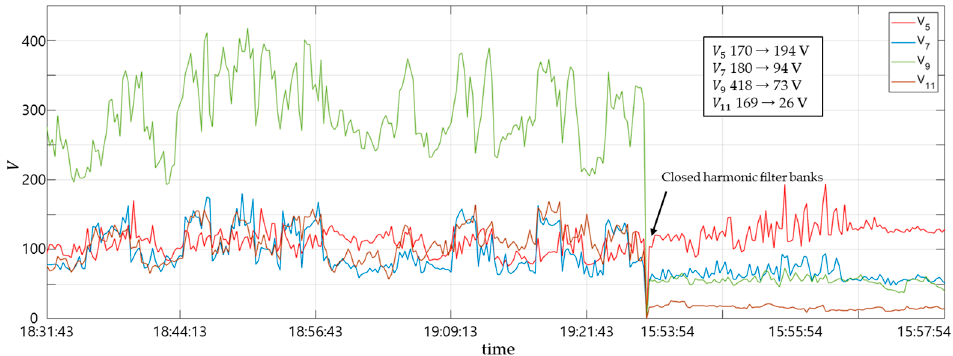
Figure 10. Measured V h ( 5, 7, 11, 13 ) for 22 kV system.